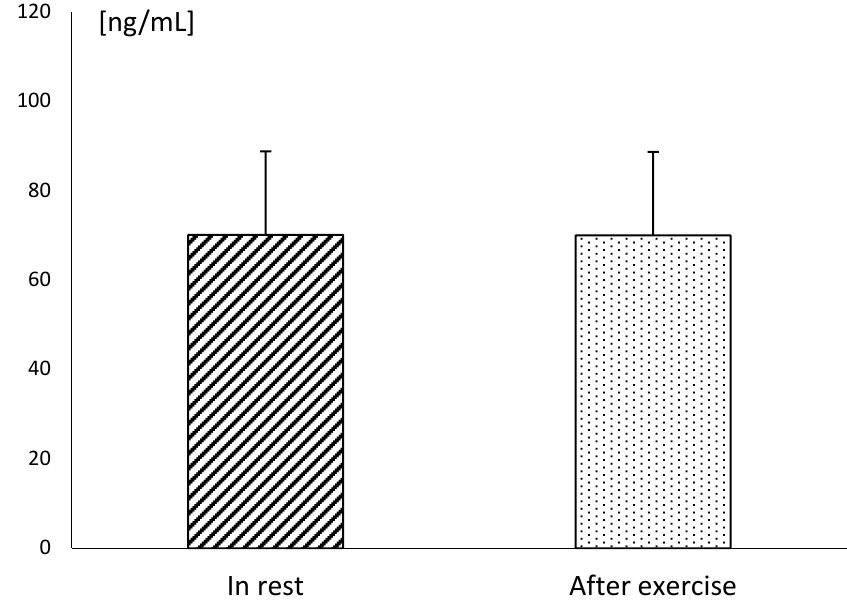
Figure 2. The mean values of irisin concentration in blood plasma in endurance horse in rest and after the end of the run at the distance of 60 km. Error bars represent standard errors ( n = 10). Di ff erences between the concentrations of myostatin obtained in MAY and SEP were statistically insignificant, both before and after exercise (Figure 3). The mean resting concentration of myostatin